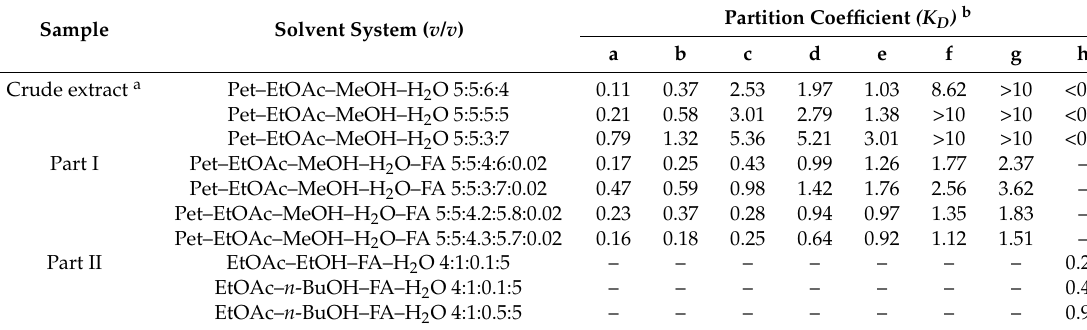
Table1. Partition coefficient ( K D ) of the target compounds in several solvent systems. Table 1. Partition coefficient ( K D ) of the target compounds in several solvent